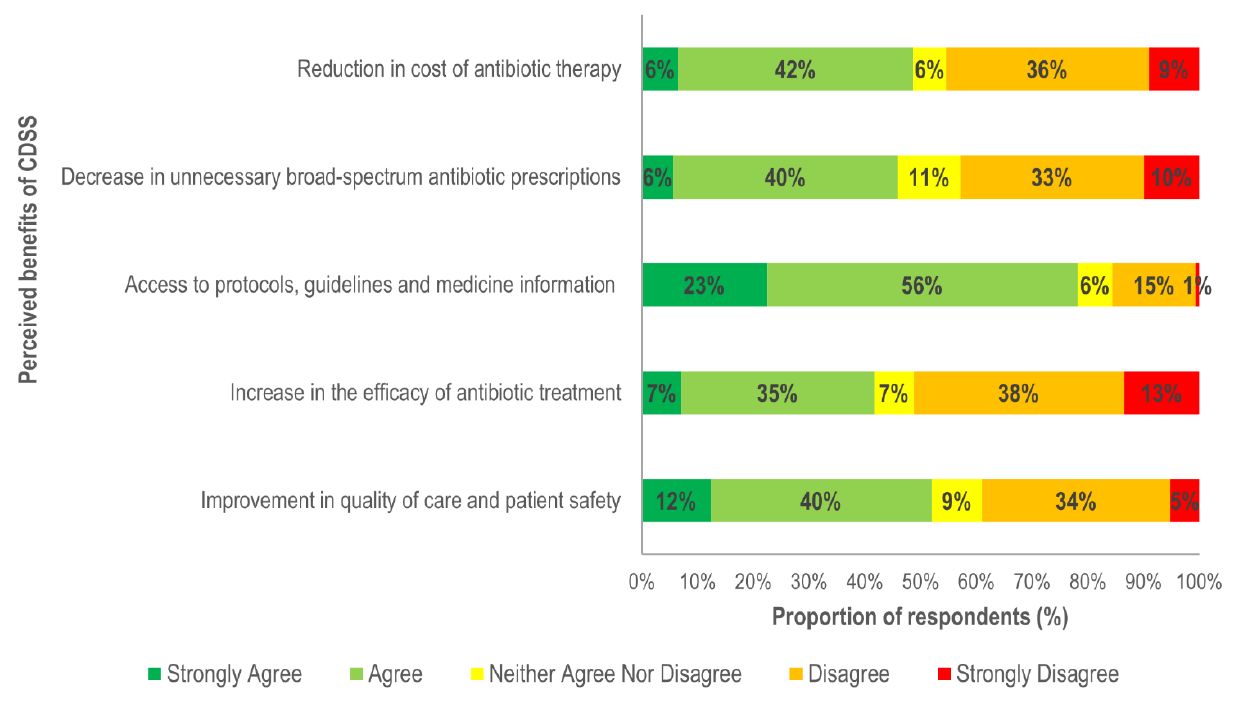
Figure 2. Overall perceived benefits of clinical decision support systems (CDSS).